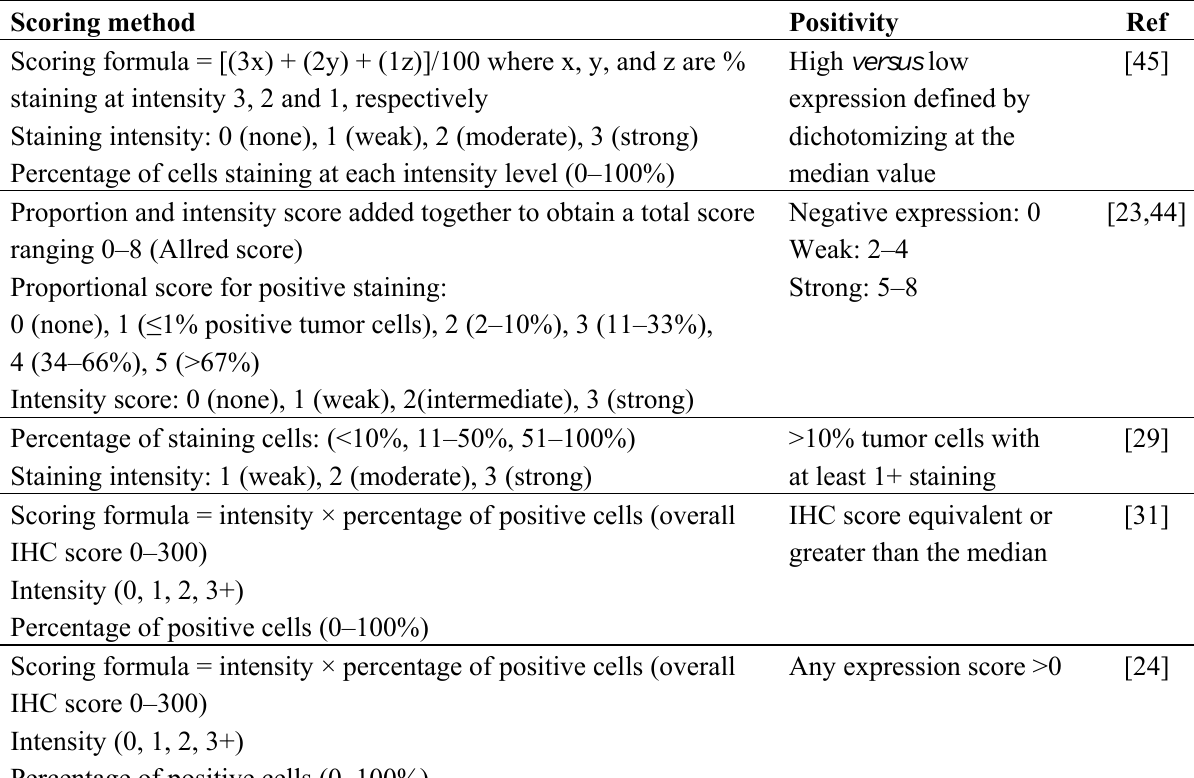
Table 2. Definitions of ER positivity in NSCLC used in